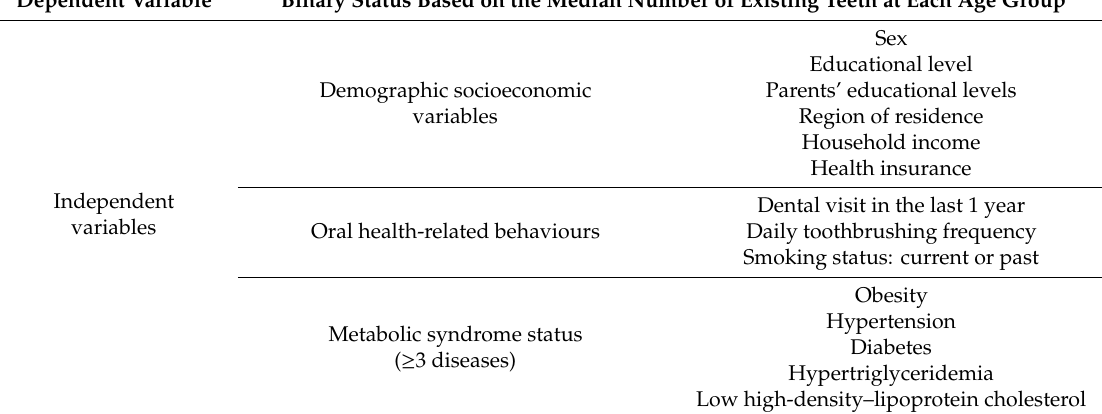
Table 1. Variables of the study.